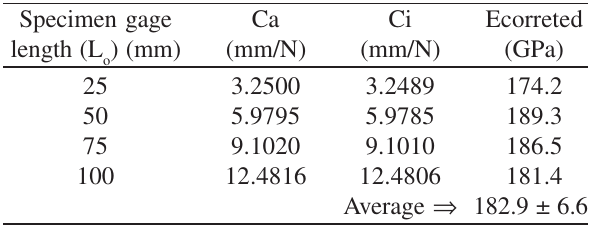
Table 4. Calculations for the corrected Young’s modulus for glass fibres, according to ASTM D